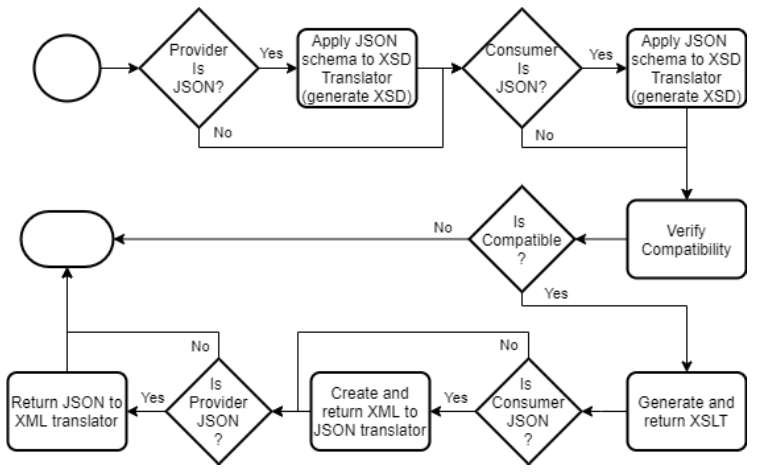
Figure 5. Extended TAG-Tool